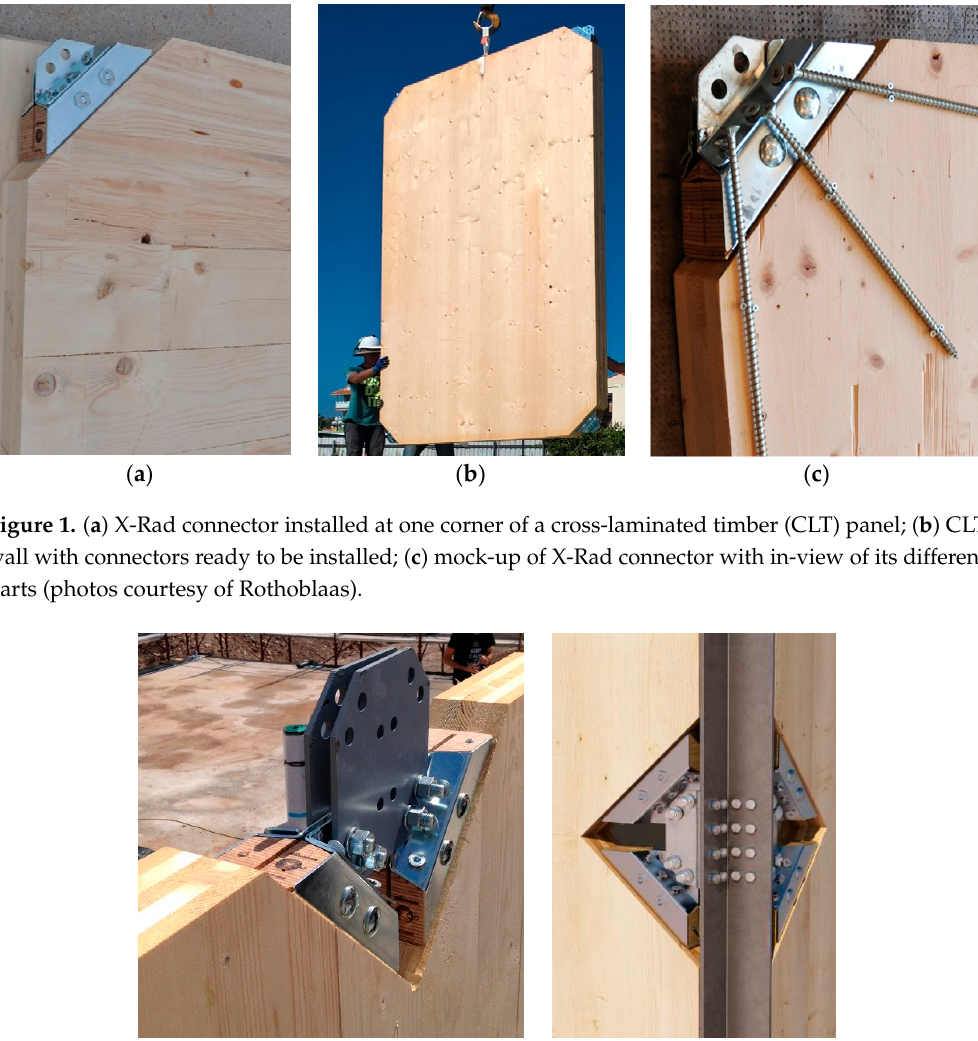
Figure 2a. Standard steel bolts are used to connect X-Rad connectors to the steel plates making pin connections between CLT elements. X-Rad connectors themselves consist of an outer metallic box,